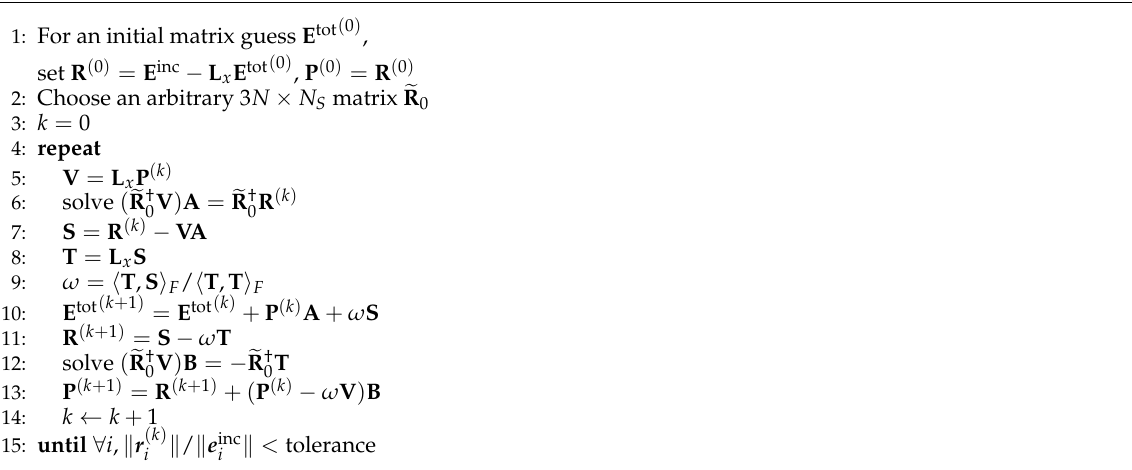
Algorithm 1 Joint resolution of N S linear systems L x E tot = E inc with block-BiCGStab.